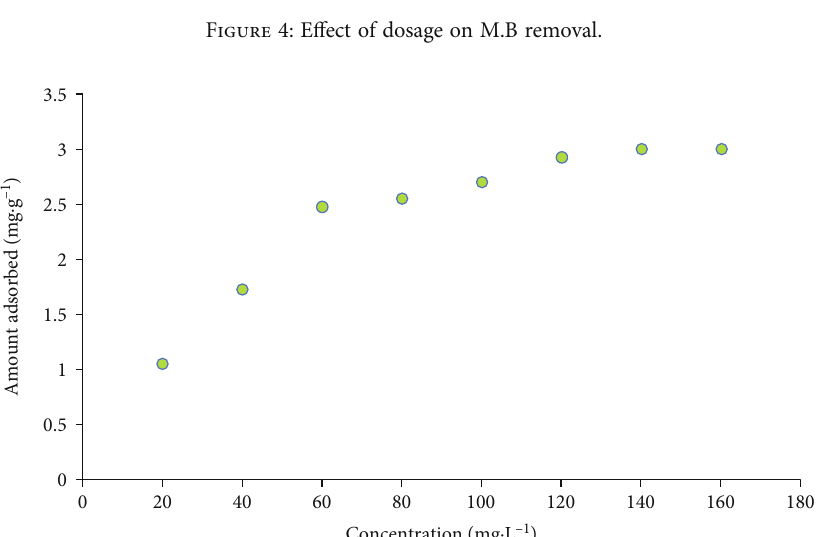
Figure 5: Adsorption isotherm plot of M.B on BTW. Table 1: Adsorption isotherm parameters of M.B on BTW. Isotherm